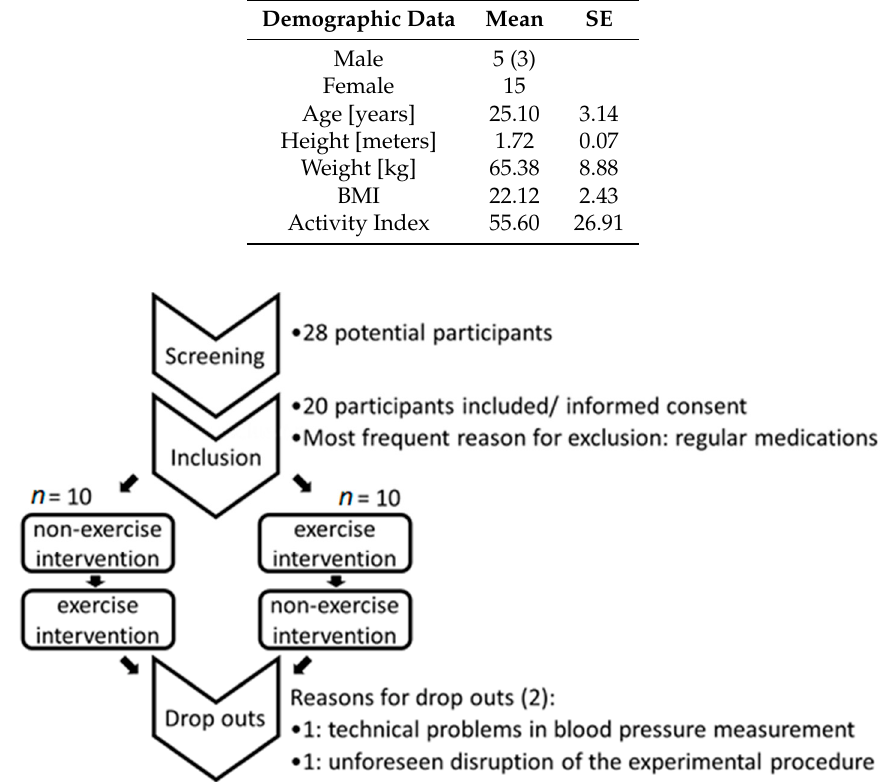
Figure 1. Flow chart of participant choice.